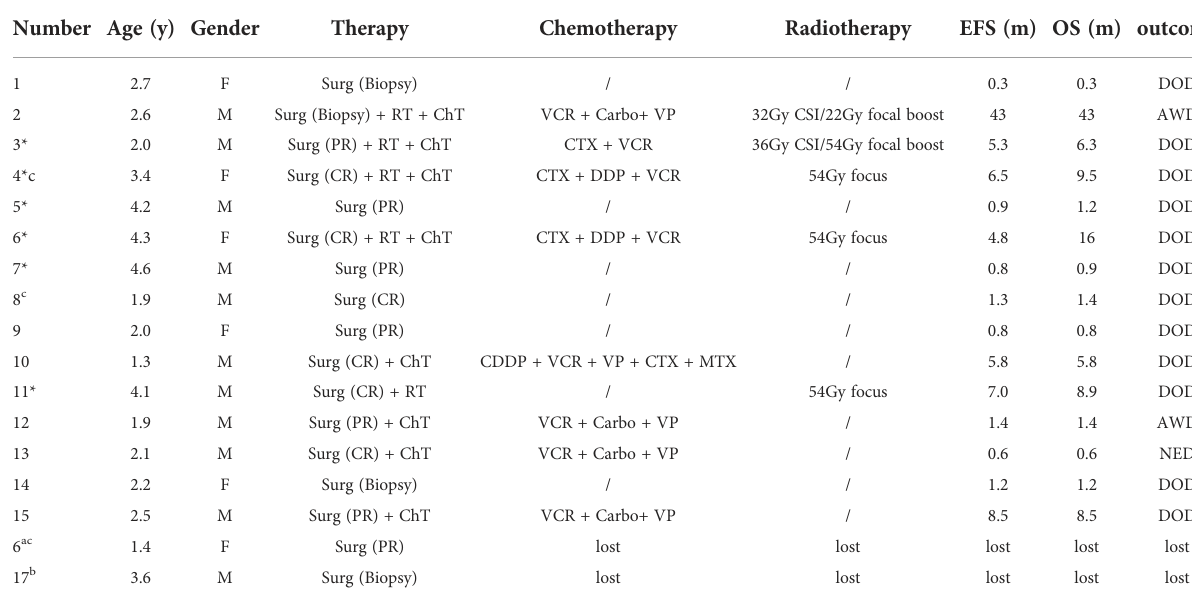
TABLE 1 Clinical details of 17 patients of